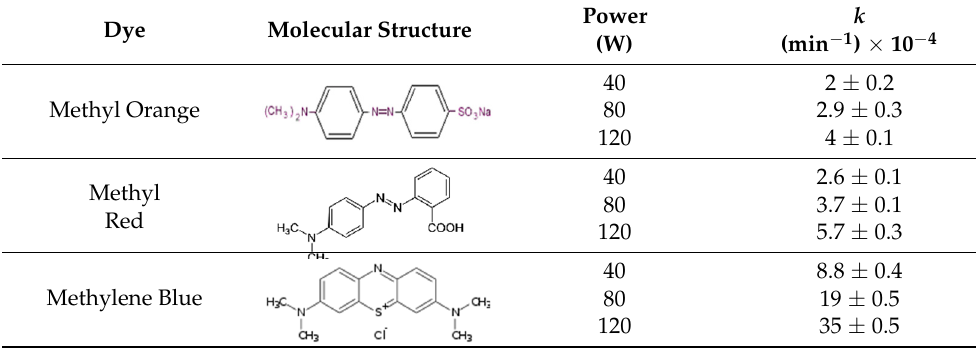
Table 2. (A) Apparent rate constants for the UV/TiO 2 photo-catalysis at different UVB intensity (tests no. 10, 16, 17) for Methyl Orange, Methyl Red, and Methylene Blue, [dye] = 0.7 mg/L; TiO 2 =